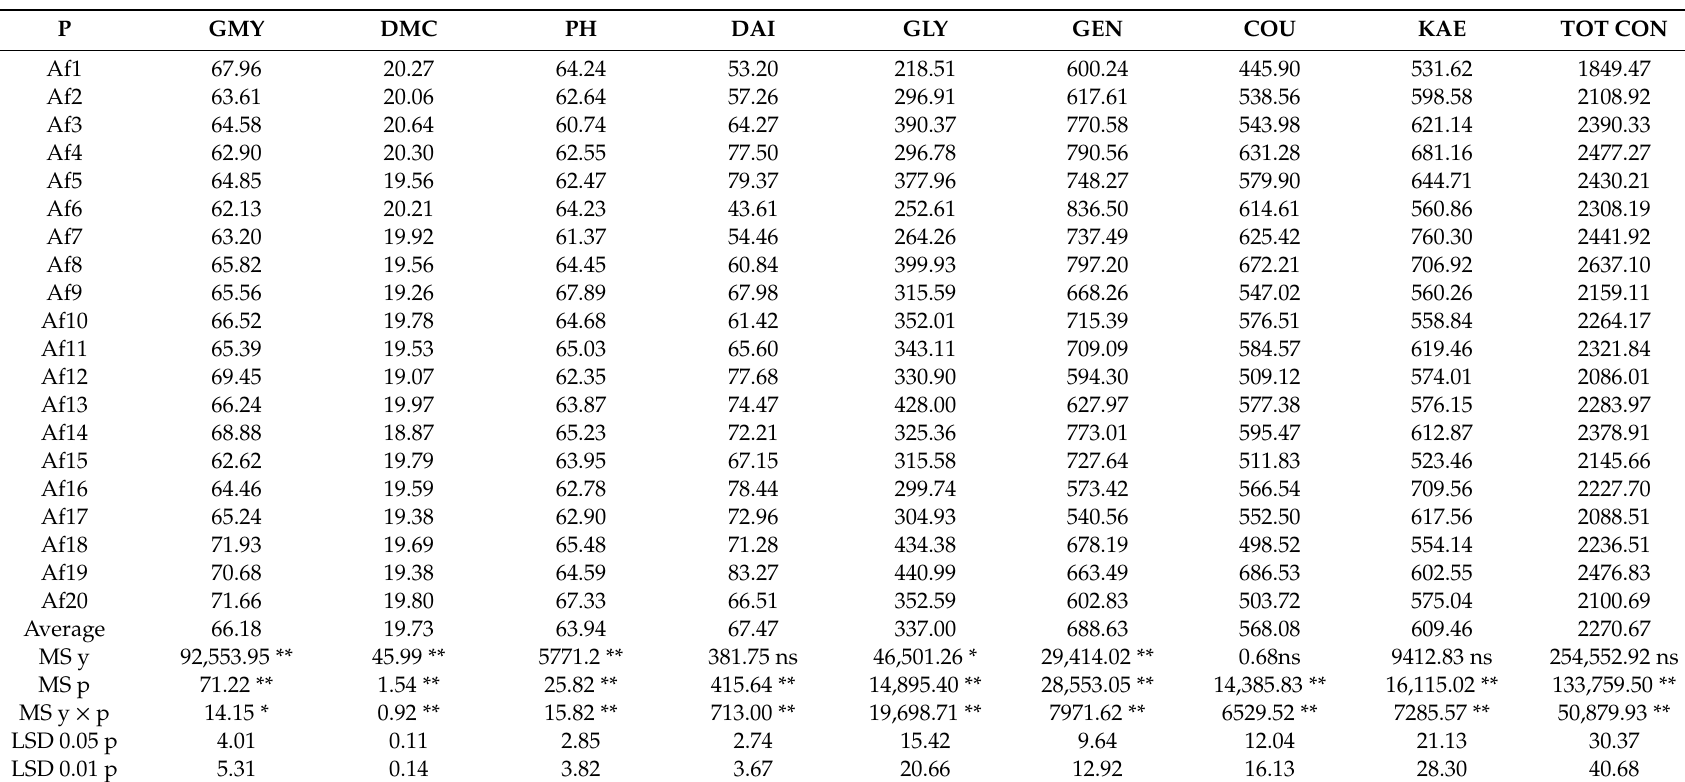
Table 2. The average values of the investigated agronomical traits (GMY—green mass yield in t ha − 1 , DMC—dry matter content in %, PH—plant height in cm) and phytoestrogen content (DAI—daidzein, GLY—glycitein, GEN—genistein, COU—coumestrol, KAE—kaempferol, TOT CON—total content in µ g g − 1 of DM) of the 20 alfalfa